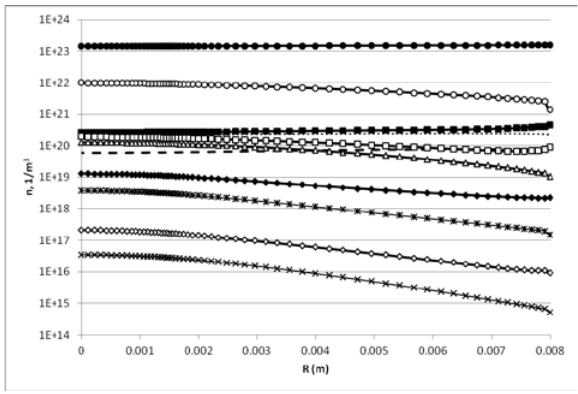
Figure 4. Profiles of the main species number densities along the substrate for model 1, 0 corresponds to the symmetry axis: H 2 — solid line, solid circles; H — solid line, empty circles; CH 4 — solid line, solid squares; CH 3 — solid line, empty squares; CH 2 — solid line, solid diamonds; 1 CH 2 — solid line, empty diamonds; CH — thin line, asterisks; C 2 H — thin line, crosses; C 2 H 2 — point line, no markers; C — solid line, empty triangles; C 3 — dotted line, no markers.